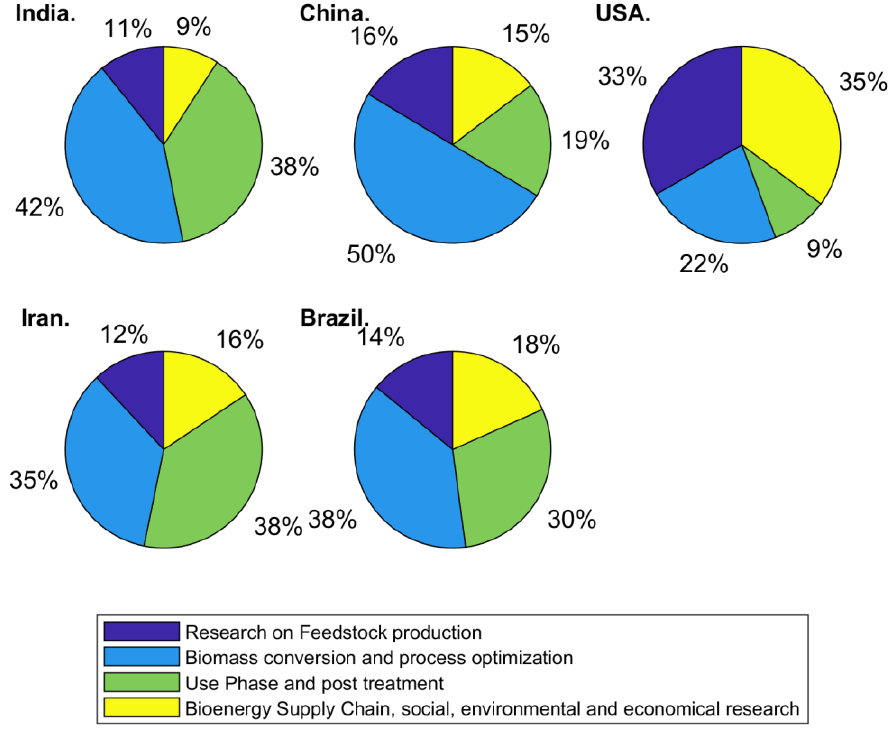
Figure 3. The category ratios of using AI in bioenergy research for the top 5 countries worldwide.